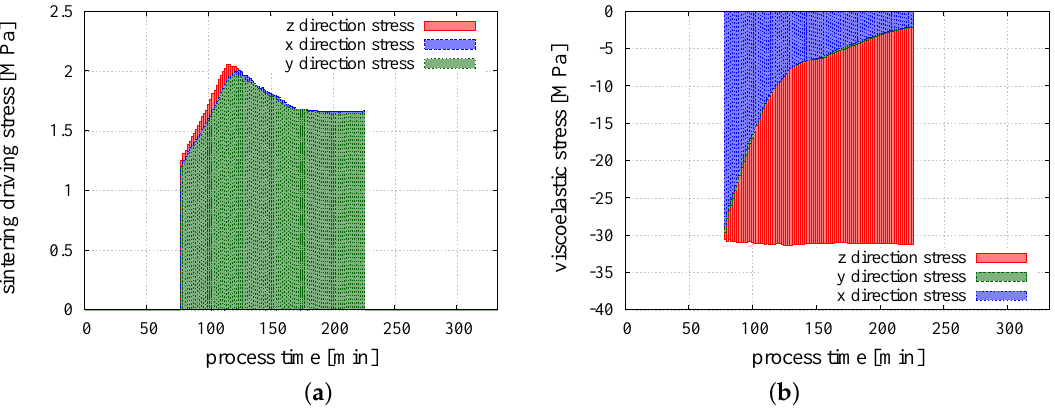
Figure 9. Evolution of ( a ) sintering driving macroscopic stress; ( b ) viscoelastic macroscopic stress of the sintering process in x , y , and z